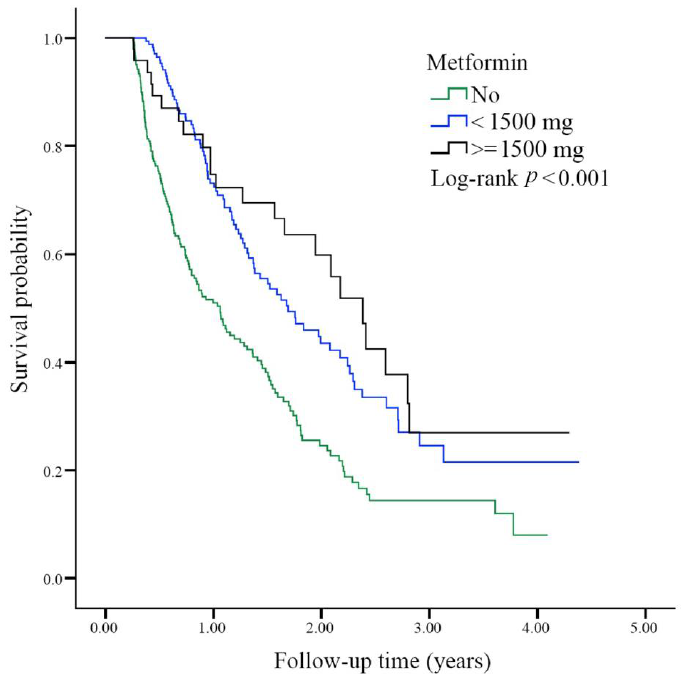
Figure 3. Overall survival status among the study groups according to the daily dosage of metformin prescribed during the first 3 months after lung cancer diagnosis. The survival probability was analyzed by the Kaplan-Meier method in the three different metformin prescription groups (0, <1500, and ≥ 1500 mg/day) of diabetic advanced lung adenocarcinoma patients. The log-rank test was p < 0.001.